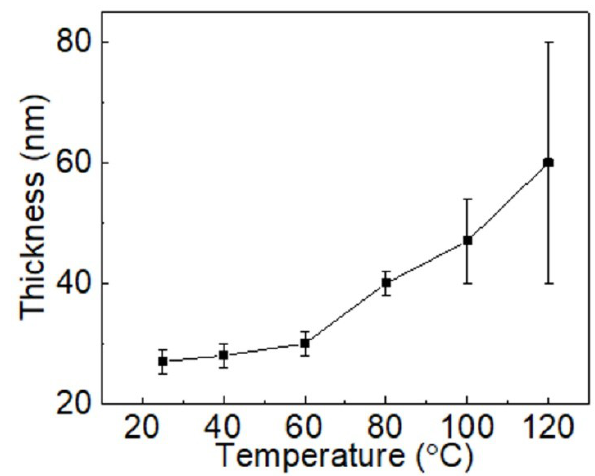
Figure 4. Thickness of PEDOT:PSS films that were deposited using the slot-die coating process at different temperatures. The coating speed and flow rate were kept constant at 1 mm/s and 1 μL/s, respectively. The vertical bars indicate the range of variation of the film thickness in the same sample.